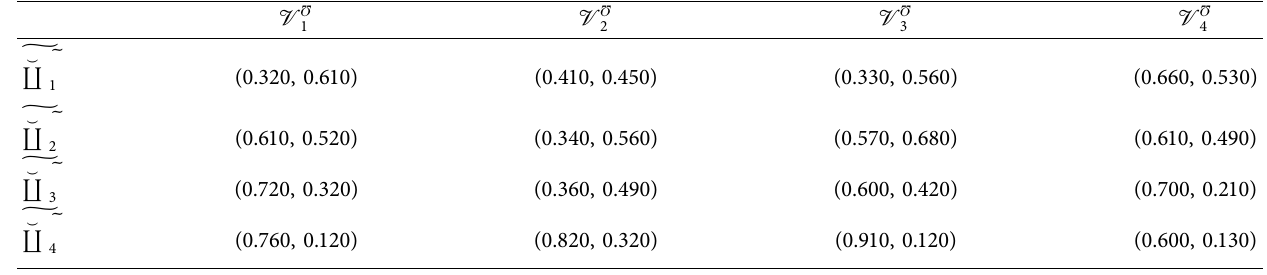
for each i . Tus we fnd aggregated PFNs by using